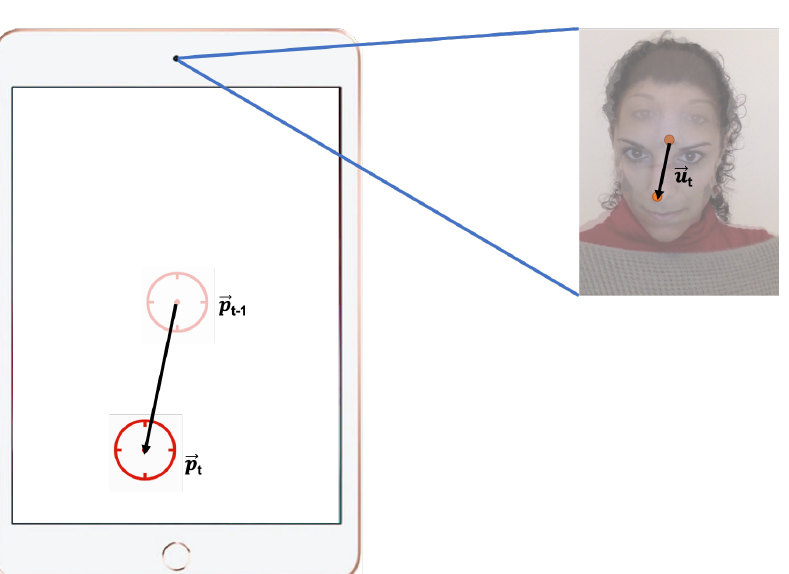
Figure 1. Calculation of (cid:126) u t ( c ) from (cid:126) n t − 1 ( a ) and (cid:126) n t ( b ).